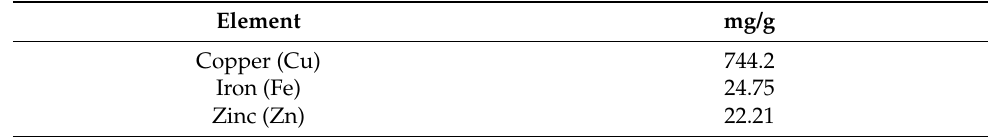
Table 1. Concentration of metals present in the